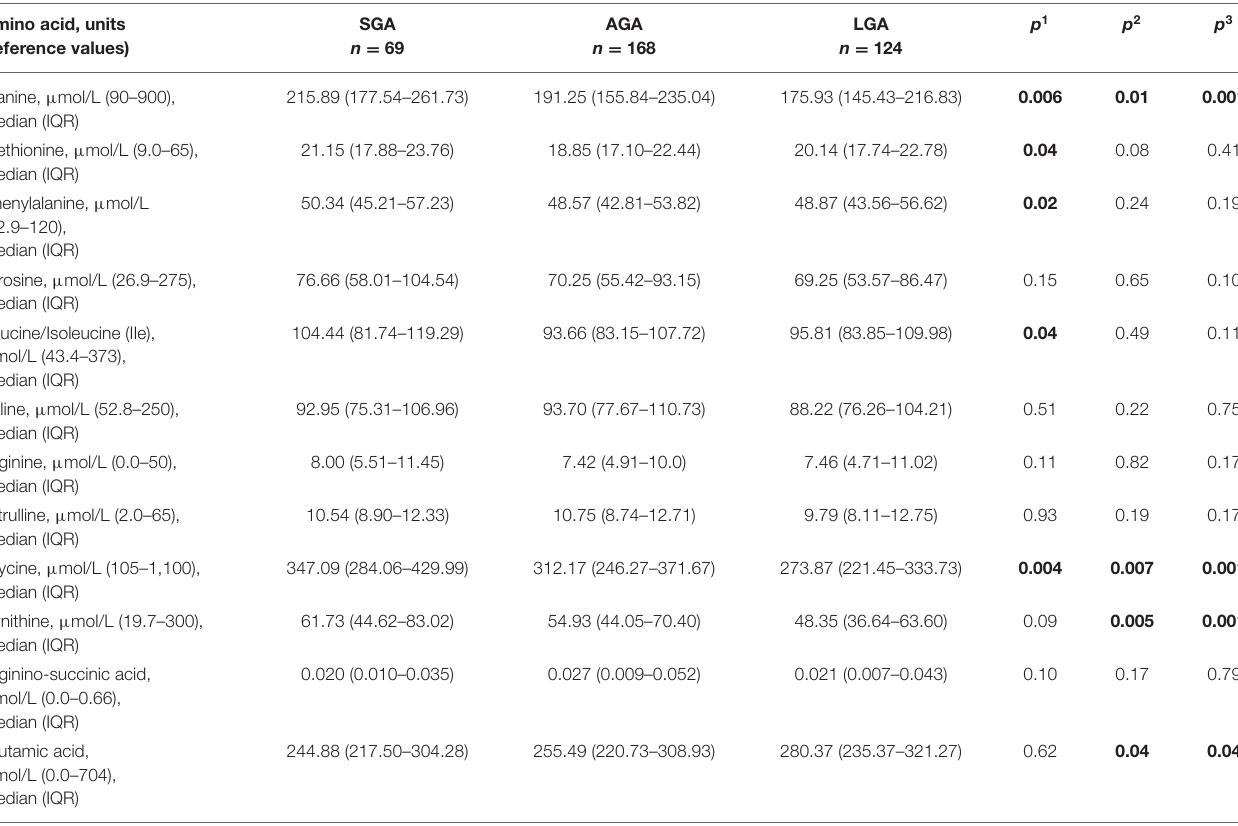
TABLE 2 | Levels of dried blood spot amino